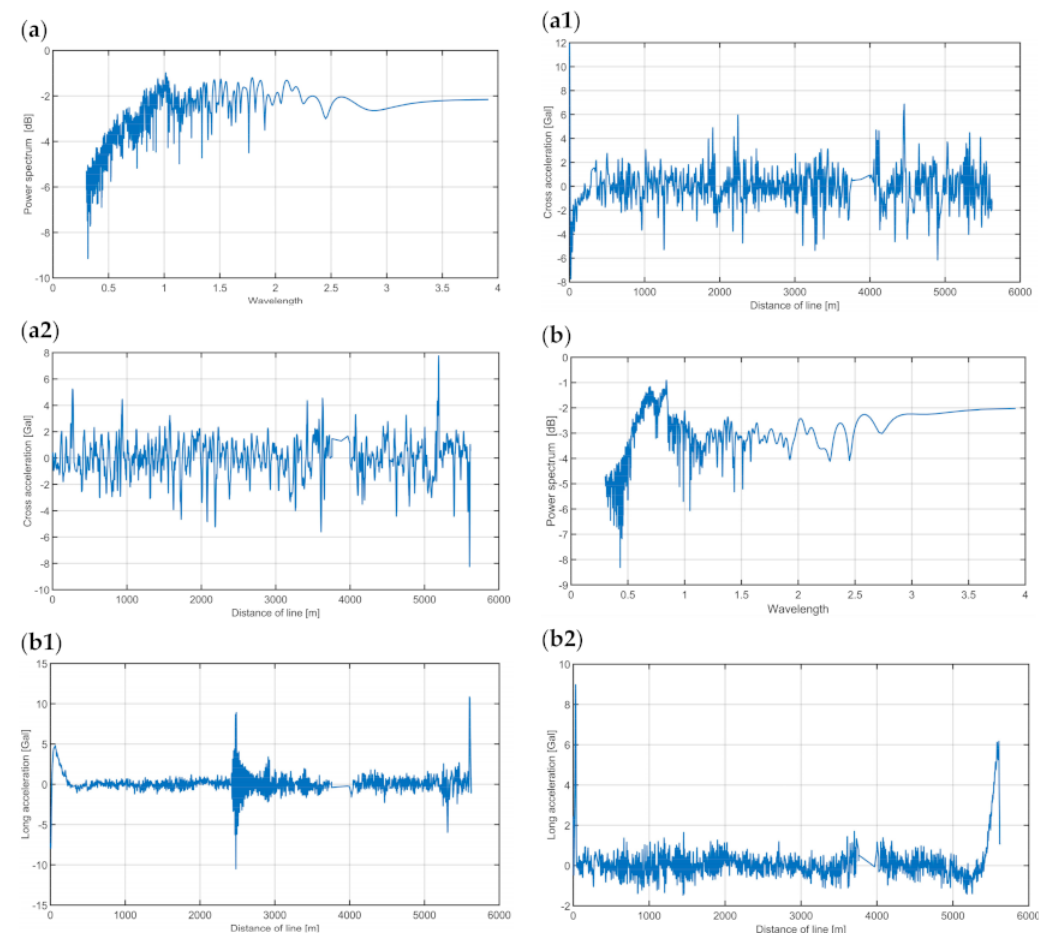
Figure 6. Signals from dilatometers installed in MGS-6. ( a ) Spectral power density for dilatometer signals for cross direction; ( a1 ) values of cross accelerations of the first profile; ( a2 ) values of cross accelerations of the second profile; ( b ) spectral power density for longitudinal direction; ( b1 ) values of longitudinal accelerations for the first profile; ( b2 ) values of longitudinal accelerations for the second